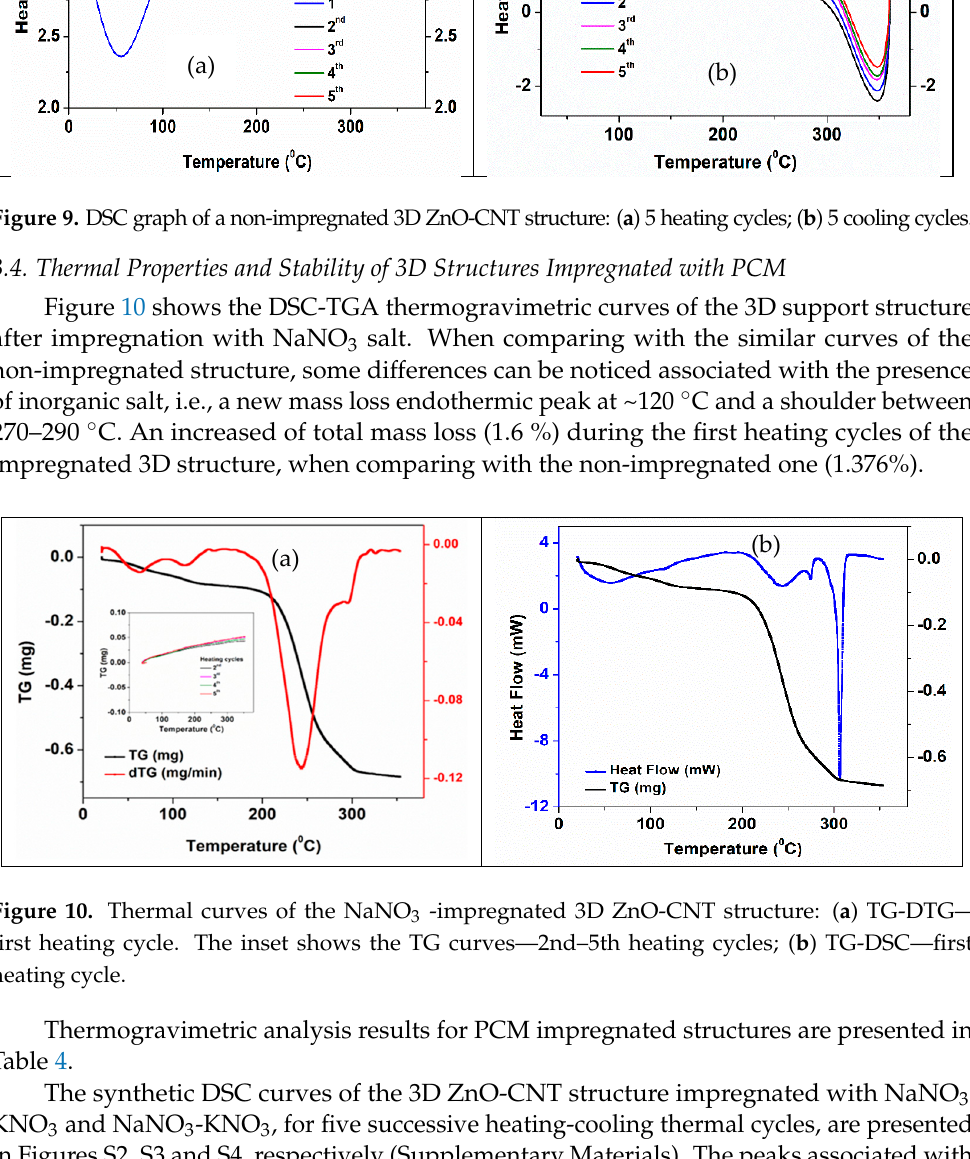
Table 4. Results of the thermogravimetric analysis for PCMs impregnated 3D structures Type of 3D Structure